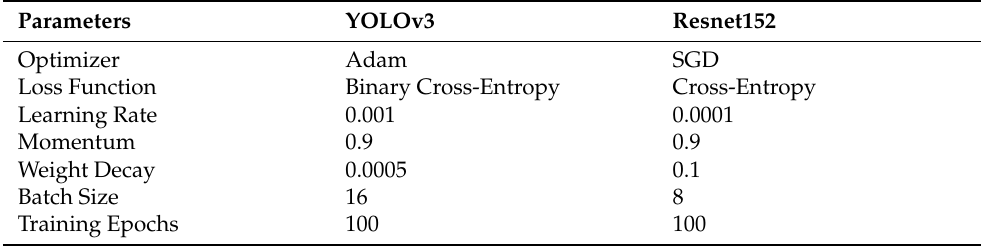
Table 1. Training parameters.